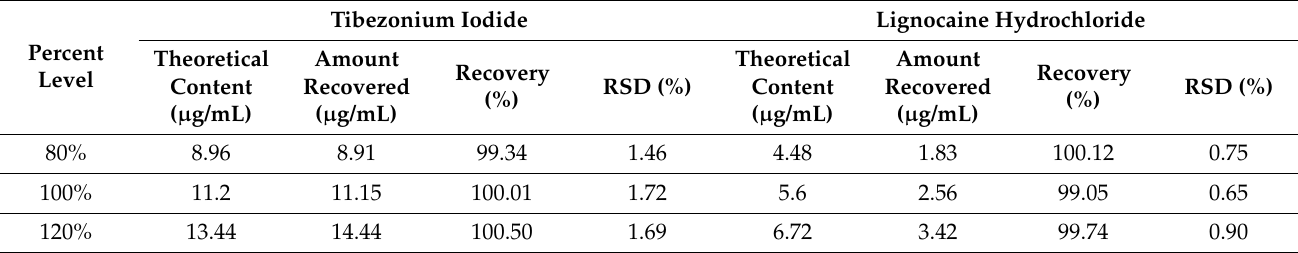
Table 2. Percentage recovery indicating the accuracy of the devised method for simultaneous detection of TBN and LGN.